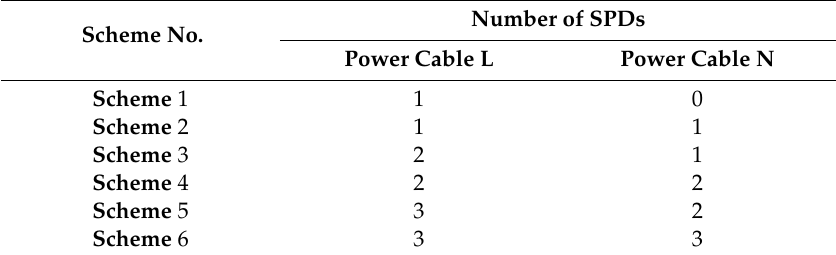
Table 4. SPD installation scheme.